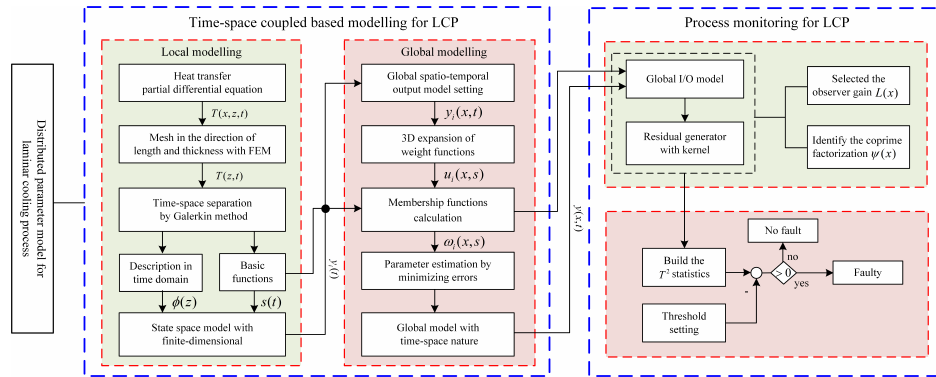
Figure 6. Flowchart of the proposed modeling and process monitoring method for LCP.